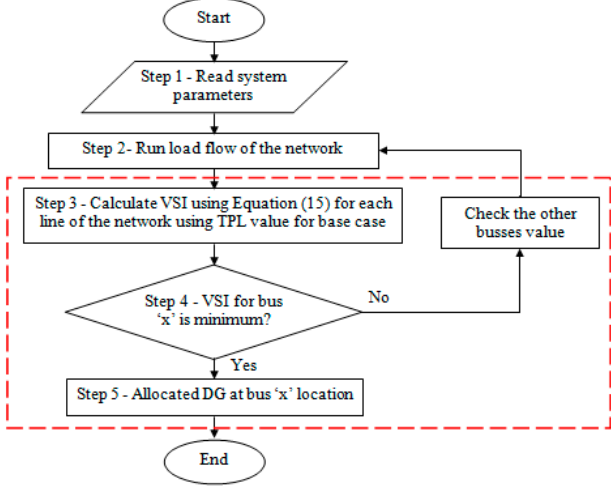
Figure 3. Process to allocate the distributed generation (DG). VSI: voltage stability index; TPL: total power losses.